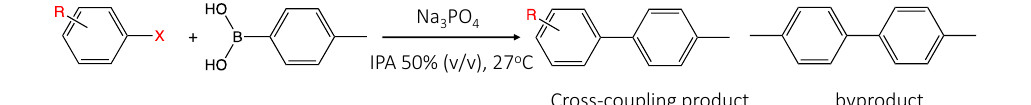
Table 3. Substrate (Aryl–X) scope of the coupling reaction.